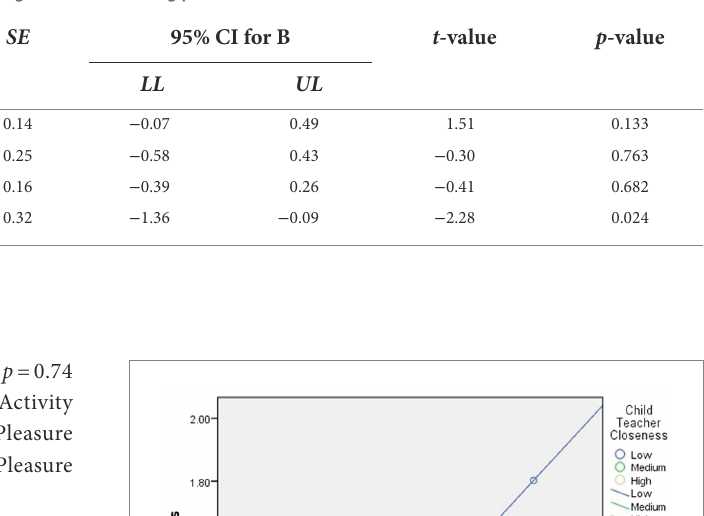
TABLE 7 Hierarchical regression analysis for variables predicting child internalizing problems.